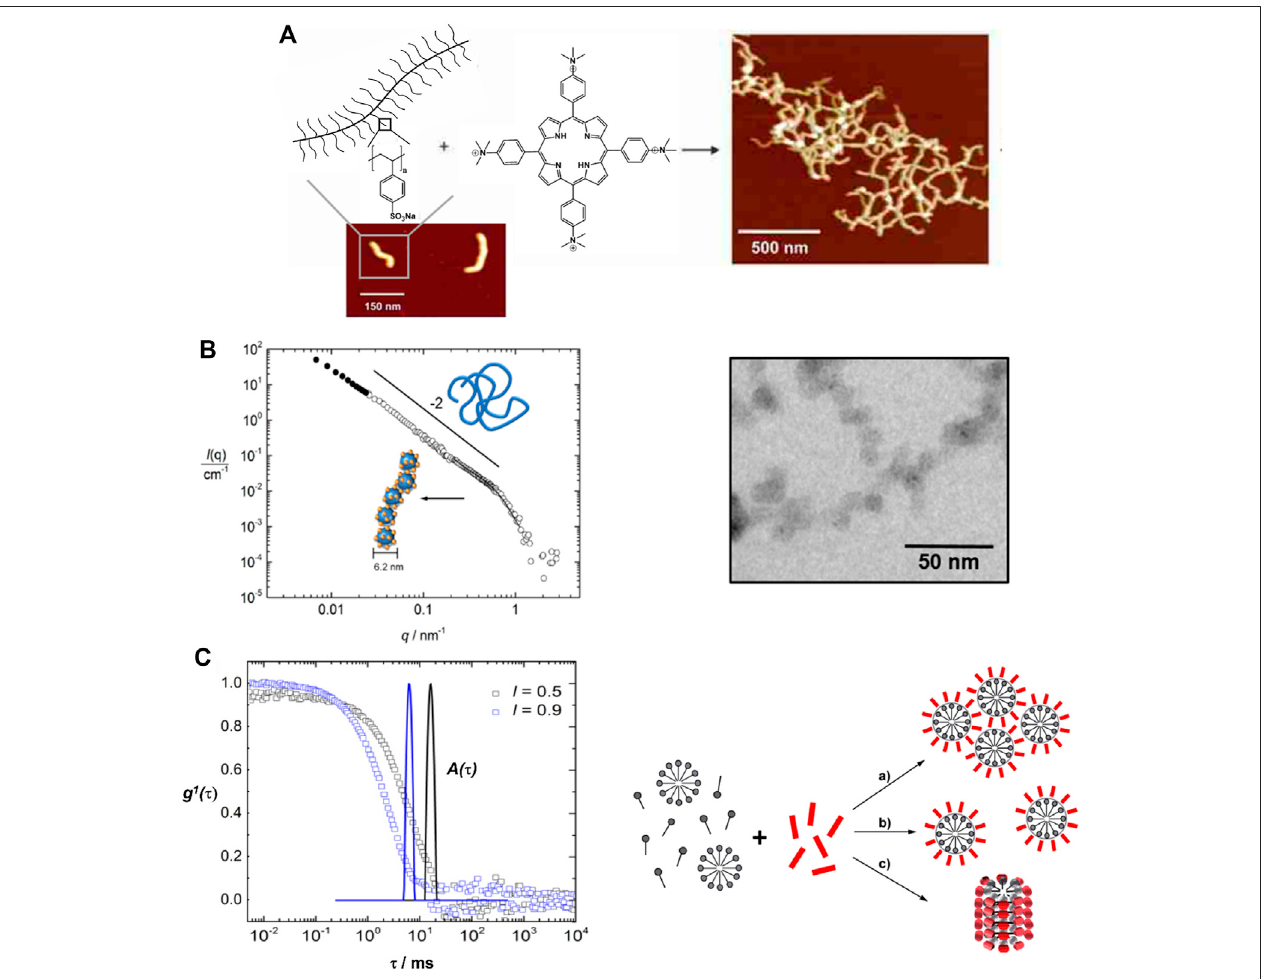
FIGURE 8 | Shape variety in electrostatic self-assembly with different building blocks: (A) Wormlike bottle-brush polyelectrolytes and tetravalent porphyrin counterions form fi nite-size networks; AFM of brush and brush-porphyrin aggregates spin-coated on mica (Ruthard et al., 2009); (B) POM – dendrimer assemblies; left: static light scattering and SANS of POM – dendrimer assemblies with l (cid:1) 0.7; fi lled symbols: SLS data, open symbols: SANS data, black line at high q: fl exible cylinder fi t; right: TEM image (Kutz et al., 2018); (C) Surfactant micelles connected by Ar26 ions as linkers; left: DLS, electric fi eld autocorrelation function g 1 ( τ ) and distribution of relaxation times A( τ ) for C 12 TAB-Ar26 assemblies; right: overview of structures formed: associated a) and individual spherical surfactant micelles b) with Ar26 molecules acting as connectors and condensed counterions, respectively, and cylindrical surfactant – dye aggregates from cylindrical surfactant micellization with condensed mutually π – π interacting Ar26 counterions c) (Kutz et al., 2016). Reprinted with permission. Copyright © 2009 American Chemical Society and © The Royal Society of Chemistry 2018 and © 2015, Springer-Verlag Berlin